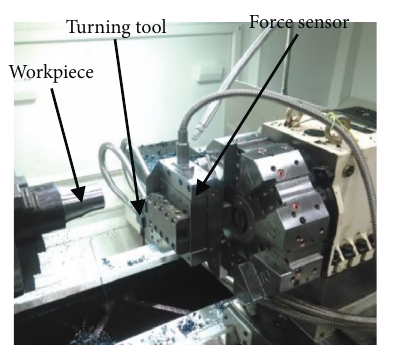
Figure 10: Surfacing machining process.